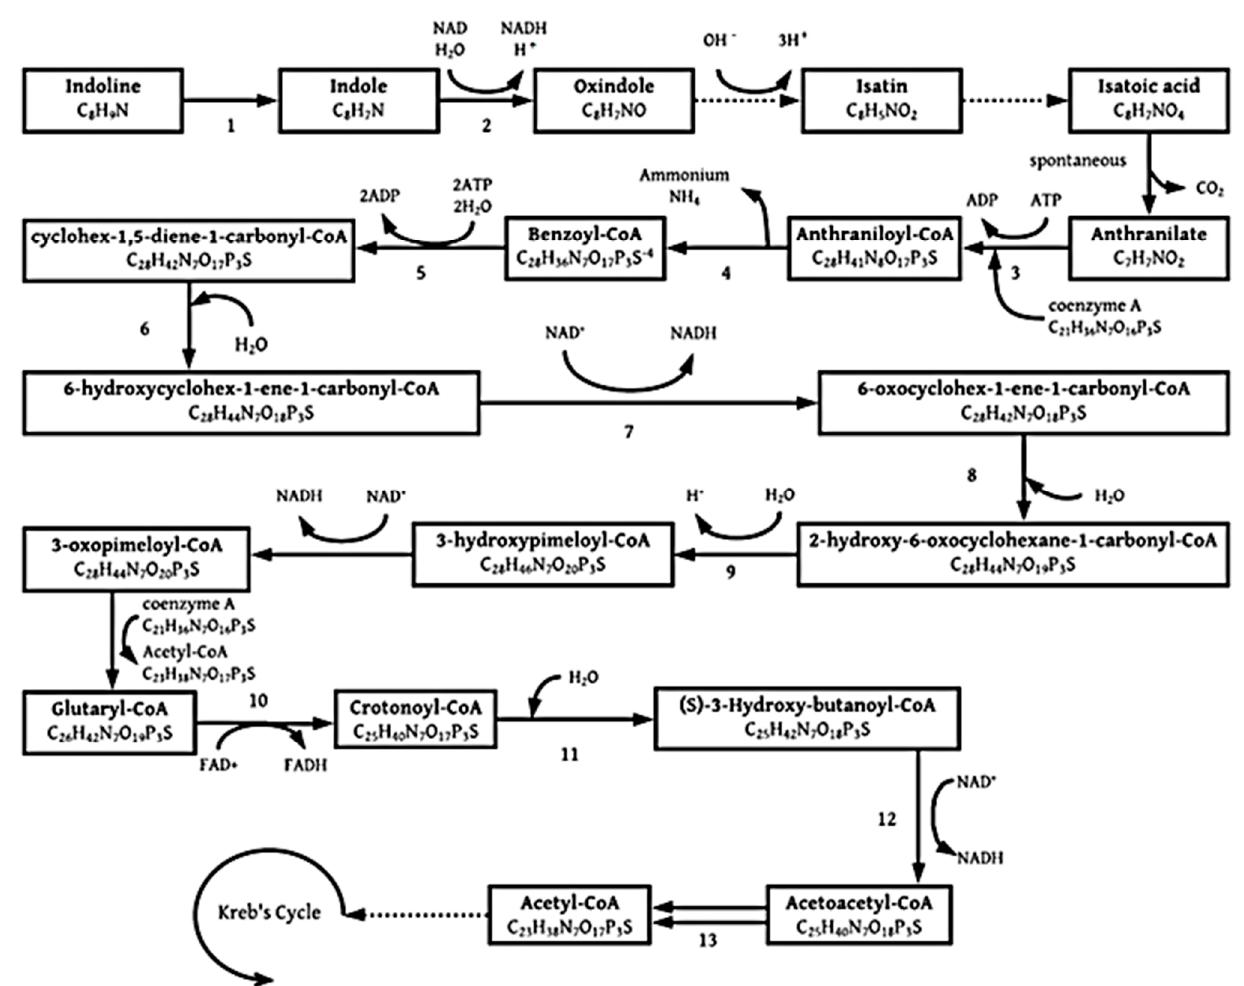
Figure 6. Catabolic pathway for anaerobic indoline degradation, enzyme activities are 1, dehydrogenases; 2, monooxy- genase [33]; 3, aminobenzoate-CoA ligase; 4, 2-aminobenzoyl-CoA reductase; 5, benzoyl-CoA reductase; 6, cyclohexa-1,5- diene-1 carboxyl-CoA hydratase; 7, 6-hydroxycyclohex-1-ene-1-carbonyl-CoA dehydrogenase; 8, 6-oxocyclohex-1-ene-1- carbonyl-CoA hydrolase; 9, 6-oxocyclohex-1-ene-1-carbonyl-CoA hydrolase; 10, glutaryl-CoA dehydrogenase; 11, enoyl- CoA hydratase; 12, 3-hydroxyacyl-CoA dehydrogenase; 13, acetyl-CoA C-acetyltransferase [26–33].